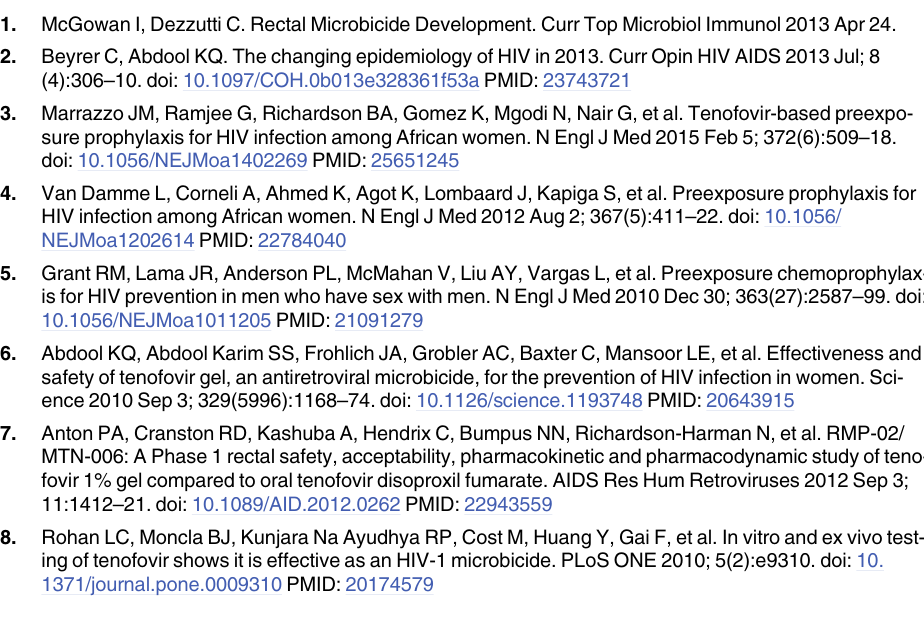
S1 Fig. Gating strategy for CHARM-01 flow cytometry panels. S2 Fig. Plasma TFV kinetics.